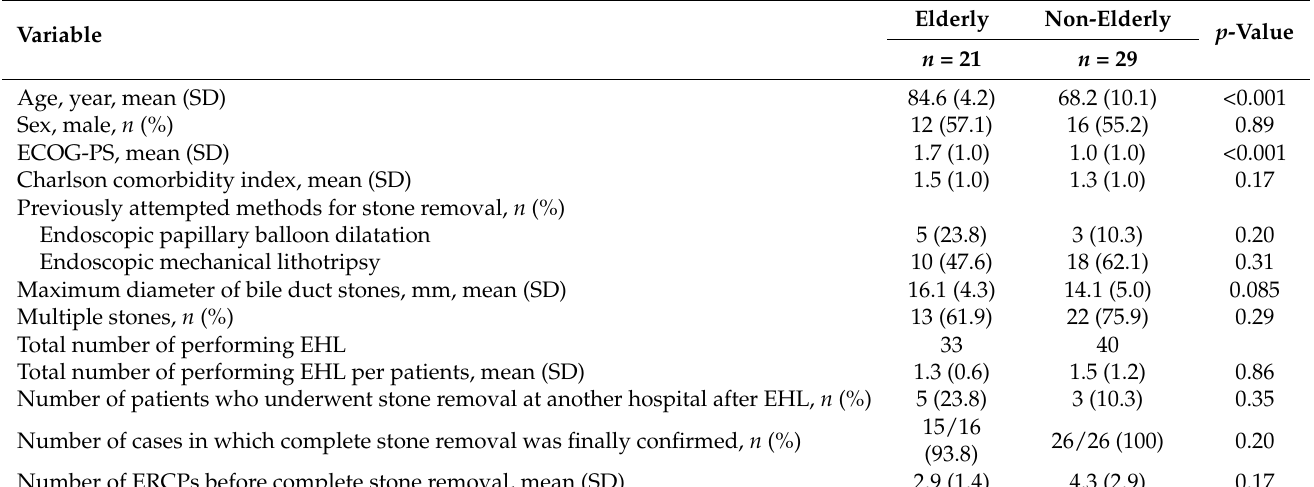
Table 3. Comparison of baseline characteristics and final treatment results between the elderly and non-elderly